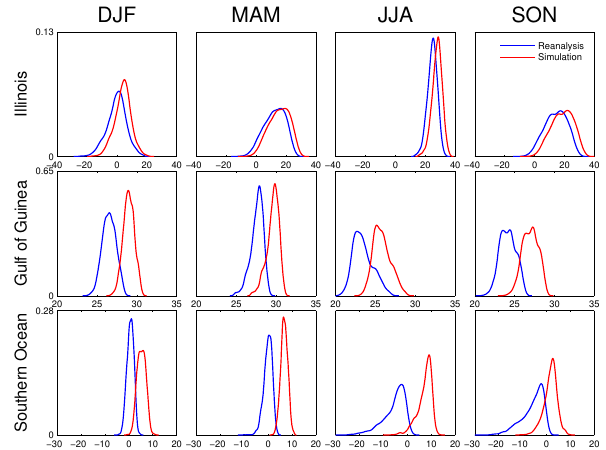
Figure 8. Marginal densities (by season) of daily temperature ( ◦ C) for the pixels at Illinois (top row), Gulf of Guinea (middle row), and Southern Ocean (bottom row) for reanalysis (blue line) and the simulations (red line). The simulations display marginal tail behav- ior similar to the reanalysis